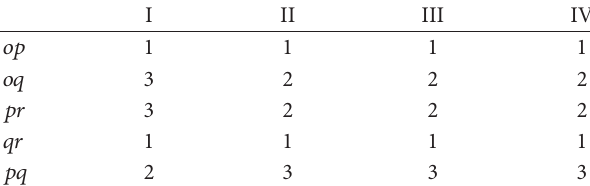
Table 2: Important rankings of links in different ranges.